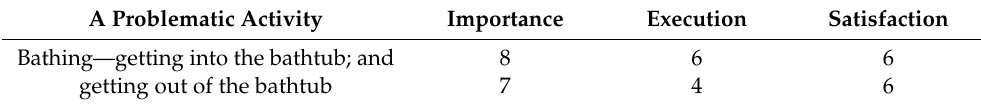
Table 2. Assessment of activity performance and satisfaction level for COMP (86-year-old woman). A Problematic Activity